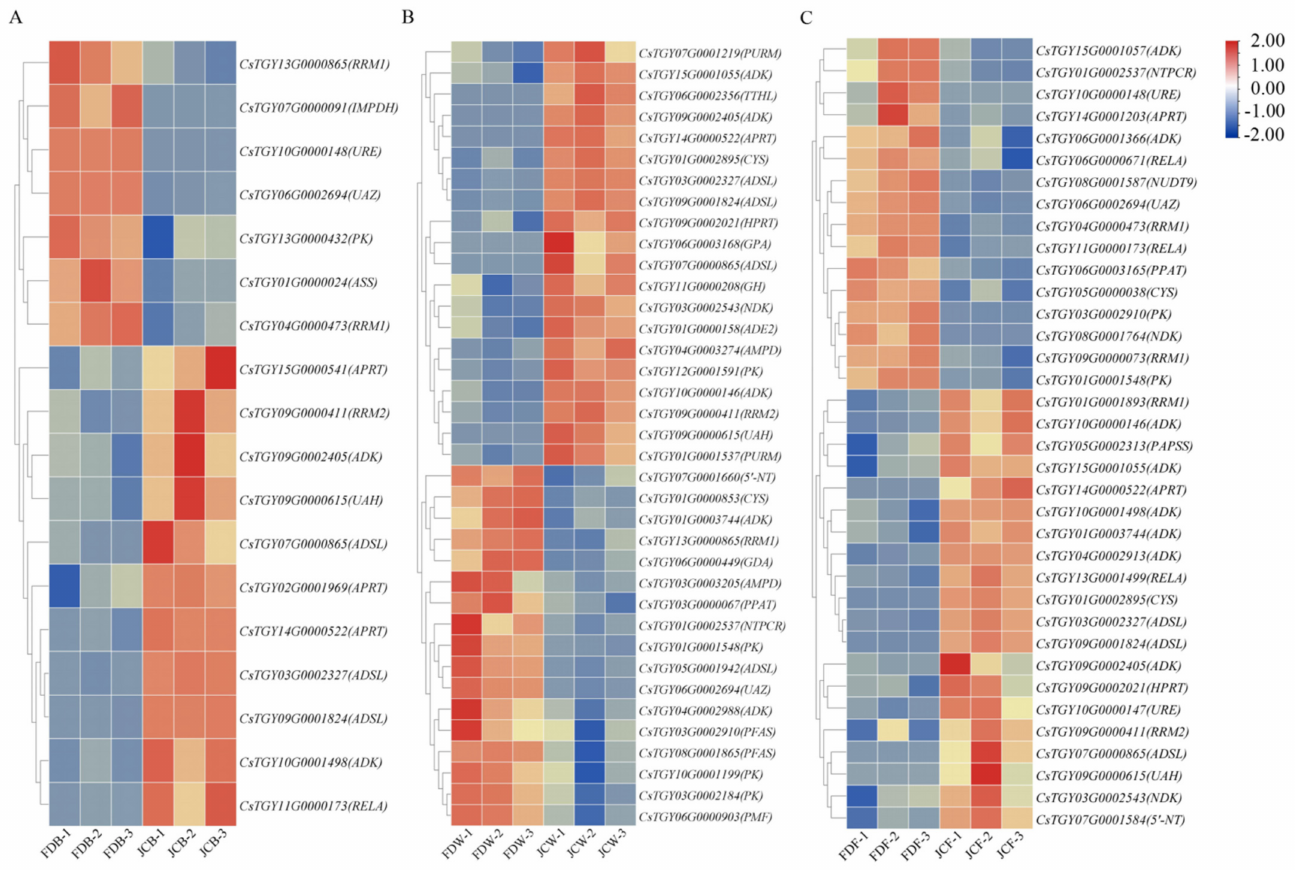
Figure 6. The heatmap of DEGs in the synthesis pathway of purine alkaloids. DEGs in flower bud stage ( A ), DEGs in whitening stage ( B ), DEGs in full opening stage ( C ).